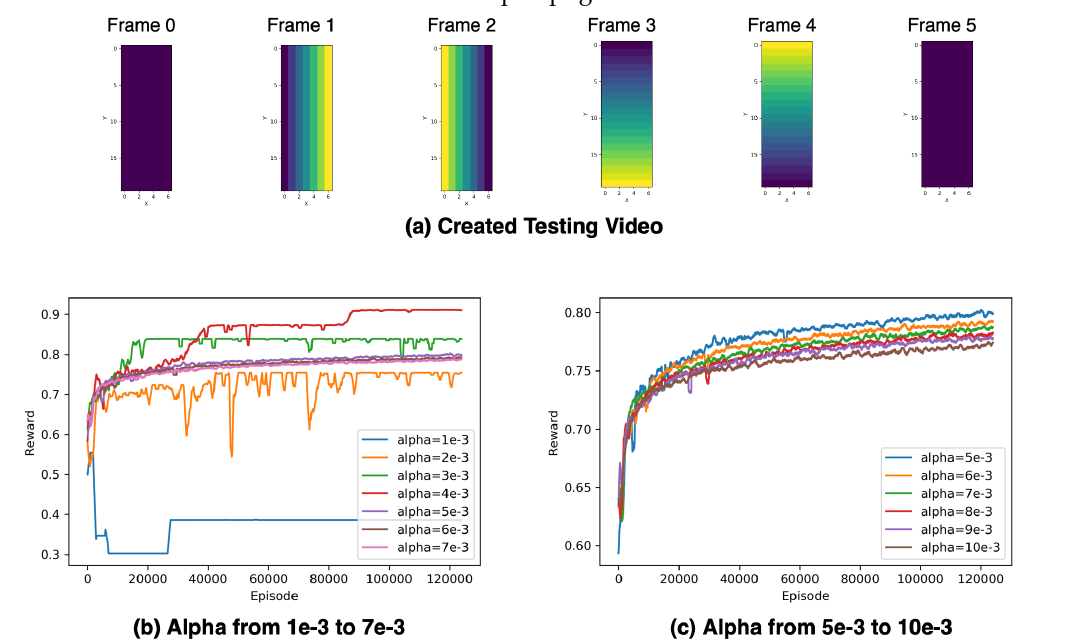
Figure 6. Illustration of created testing video and episodic rewards. ( a ) The first and last frames are empty images without any pressure. Using a simple increase and a decrease patterns to generate the rest frames, ( b , c ) are the episode reward using different temperature parameters from 1 × 10 − 3 to 10 × 10 − 3 and filtered by a moving average filter with a window size